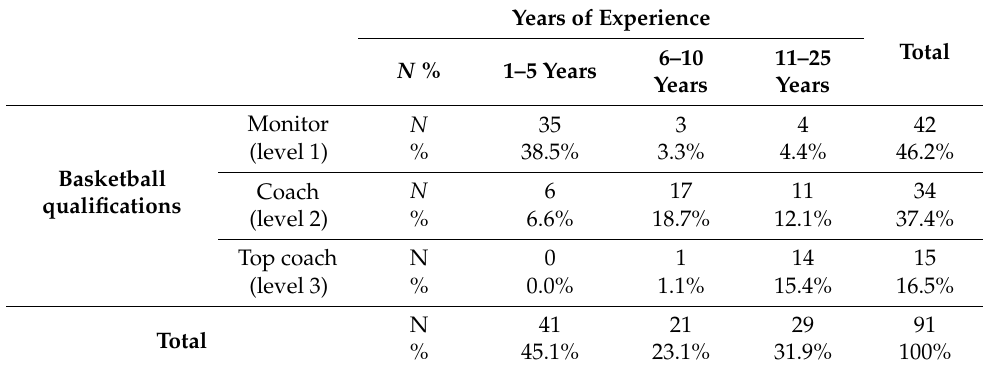
Table 1. Participants according to years of experience and basketball